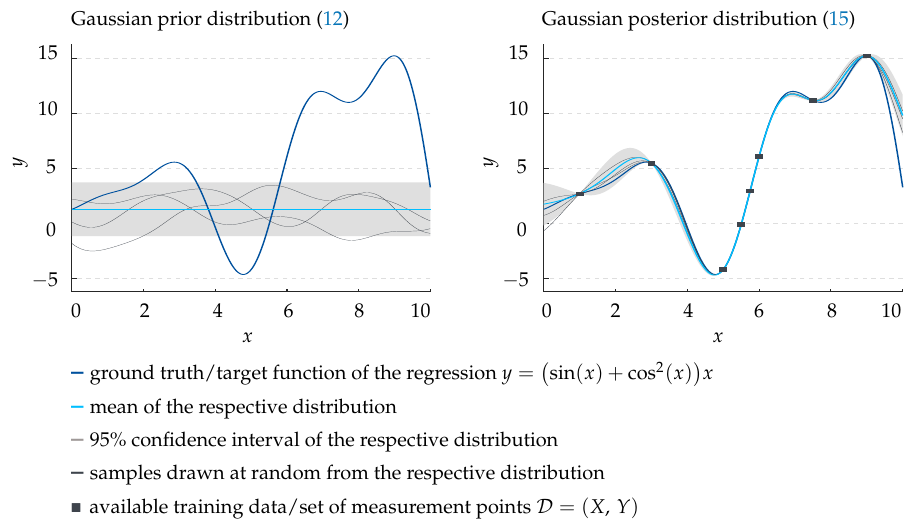
Figure 4. Visualisation of the working principle of a Gaussian process regression with an example target function. Note that both the input x ∈ R , as well as the dependent output y ∈ R in this example are dimensionless. ( Left panel ) Gaussian prior distribution (12). ( Right panel ) Gaussian conditional posterior distribution (15) approximating the underlying target function y from given measurement points D = ( X , Y )